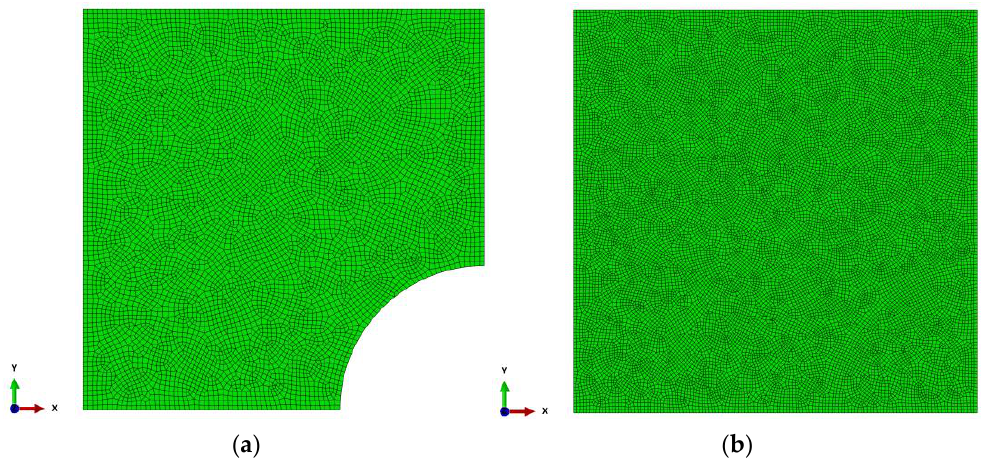
Figure 9. Meshes built from finite elements type S3 and S4R: ( a ) for the B1 case—7708 finite elements; ( b ) for case B2—19,139 finite elements.